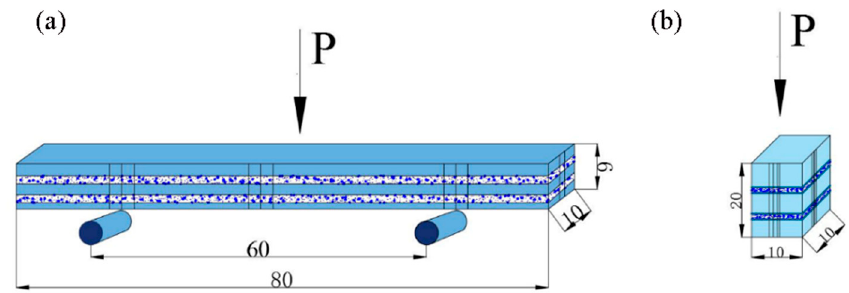
Figure 2. Test model diagram. ( a ) Loading in the Z -direction three-point bending diagram and ( b ) a compression diagram.